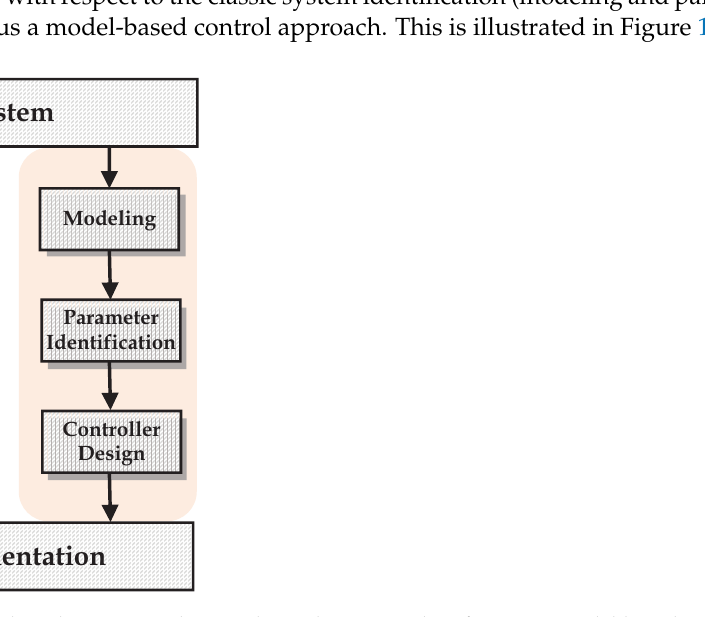
Figure 1. Proposed data-driven control vs. traditional “system identification + model-based”